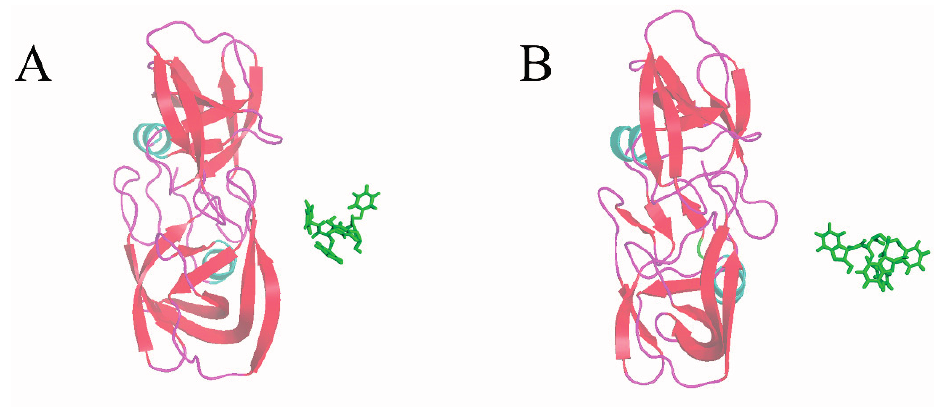
Figure 6. Final structures of the steered molecular dynamics simulations of 1d4i with ( A ) C-SMD and ( B ) SA-SMD